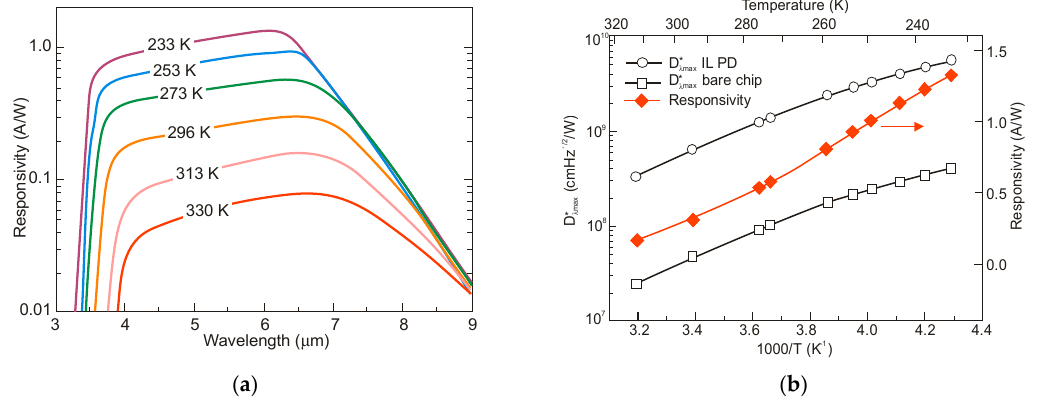
Figure 40. DH InAsSbP/InAs 0.7 Sb 0.3 p-n photodiodes grown onto InAs substrates: ( a ) photoresponse spectra in the 233–330 K interval, ( b ) maximum detectivity for bare chip ( ⧠ ) and immersion lens ( ○ ) photodiodes (left scale) and responsivity (right scale,) versus temperature in a 195- μ m wide bare chip (after [125]).